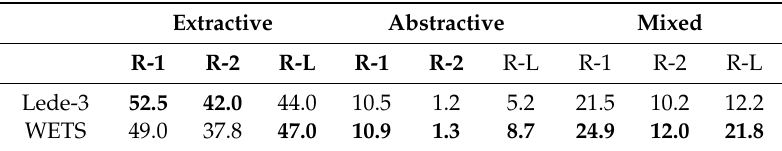
Table 4. ROUGE scores of WETS and Lede-3. For this experiment, we used pairs of article-summary dataset that described in Table 1. The articles are the source text from which Lede-3 and WETS summaries were generated while the paired summaries are used as a reference (ground truth) to evaluate both Lede-3 and WETS. Better results are highlighted